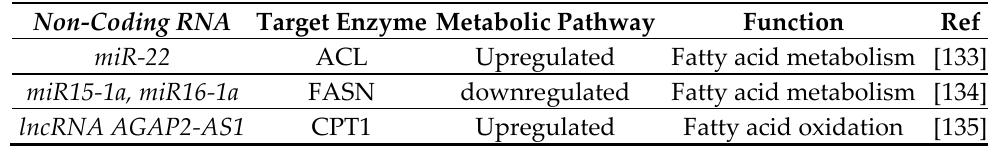
Table 2. Summaries of ncRNAs that exert their regulatory effect by modulating lipid metabolism key enzymes in reprogramed